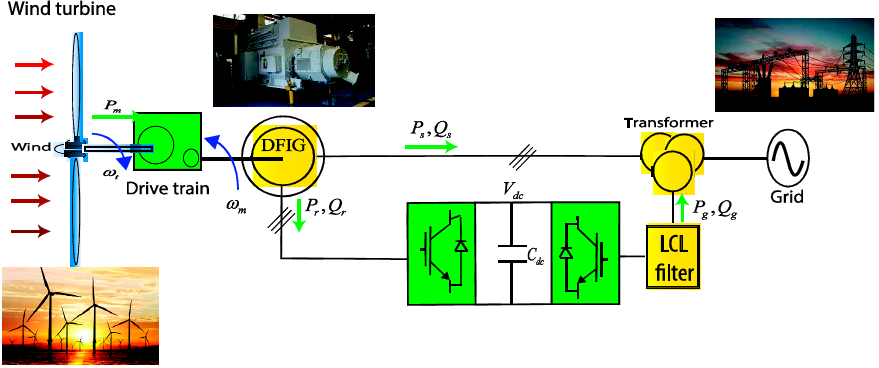
Figure 1. Configuration of the Doubly Fed Induction Generator (DFIG)-based Wind Energy Converter System (WECS).